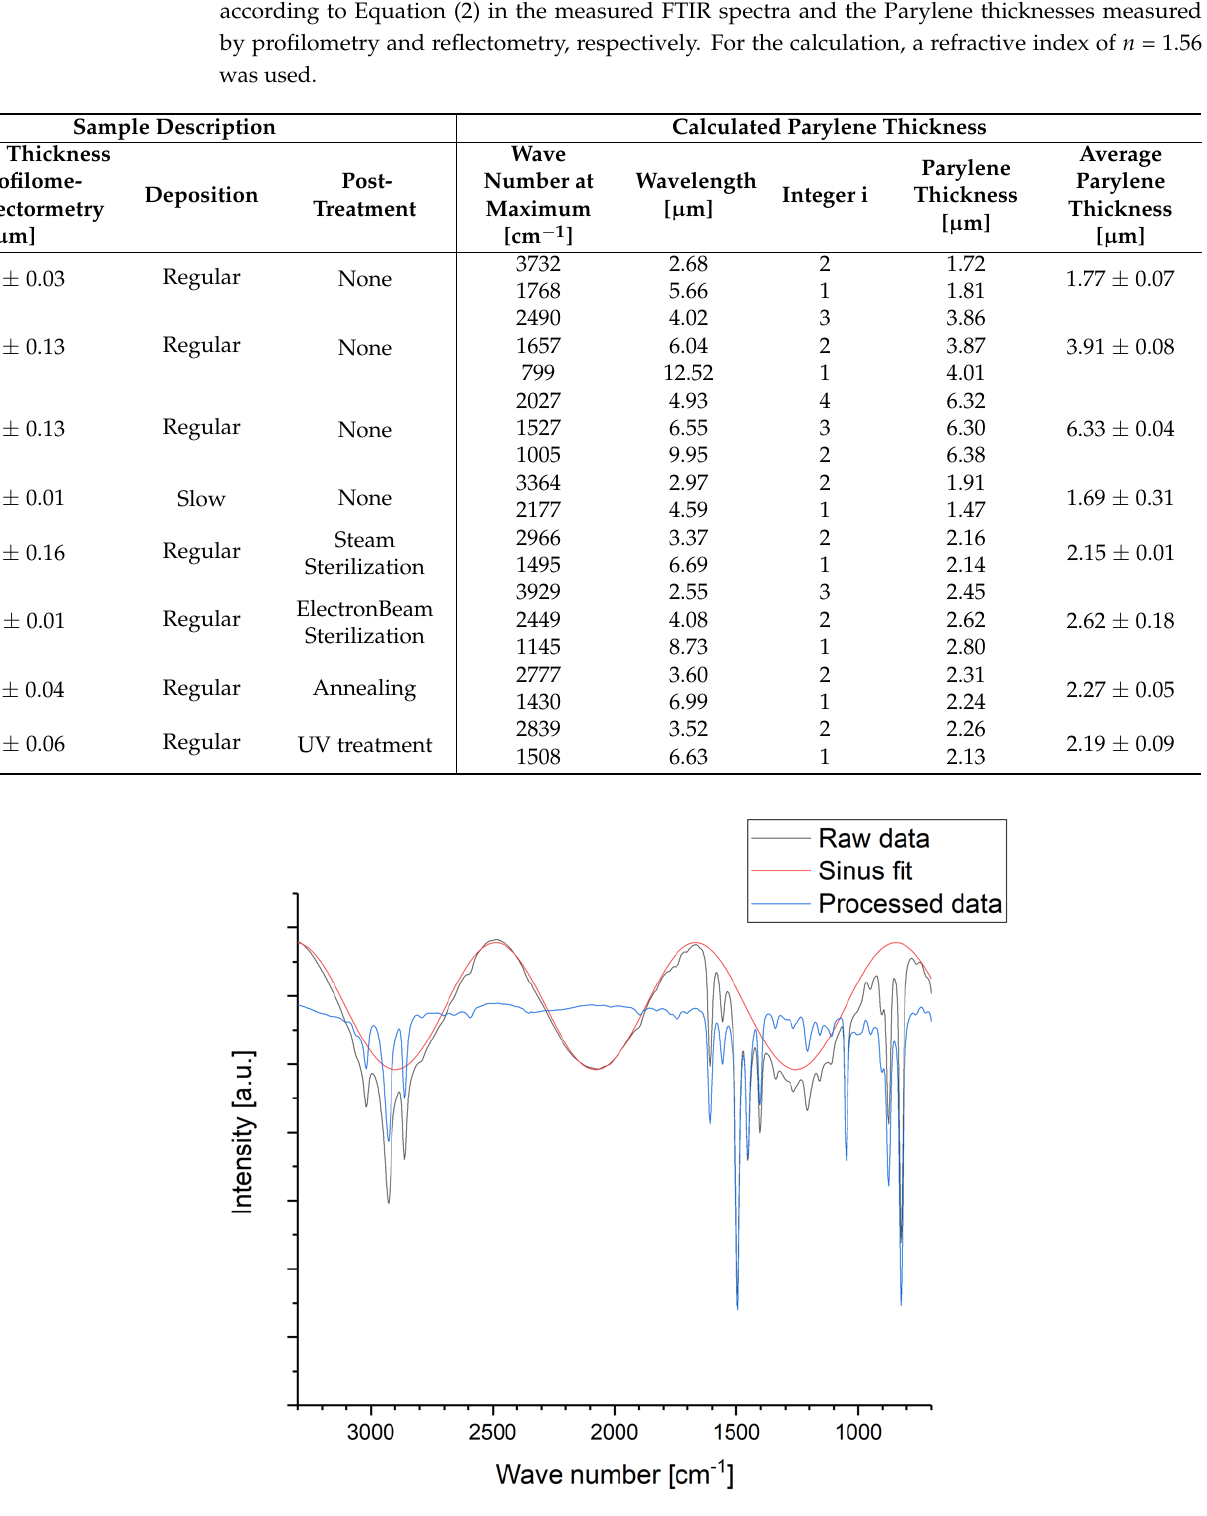
Figure A1. Example for the post-processing of the measured FTIR raw data to smooth the spectra: The raw data are subtracted by a fitted sinus function to obtain the processed data.